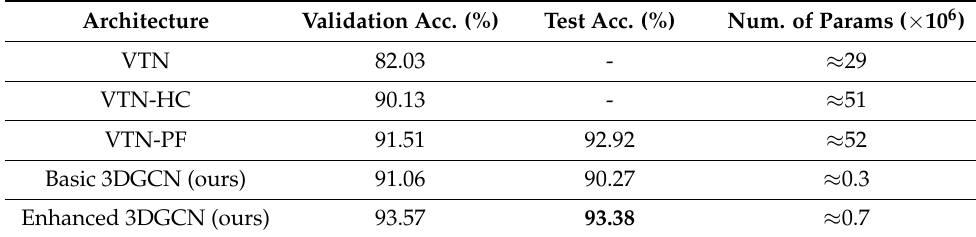
Table 3. Performance comparison on the AUTSL dataset.